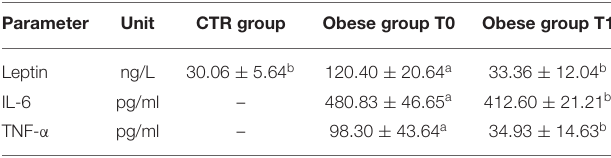
TABLE 5 | Leptin and inflammatory cytokines in the control (CTR) and obese groups before and after the weight loss program (WLP).